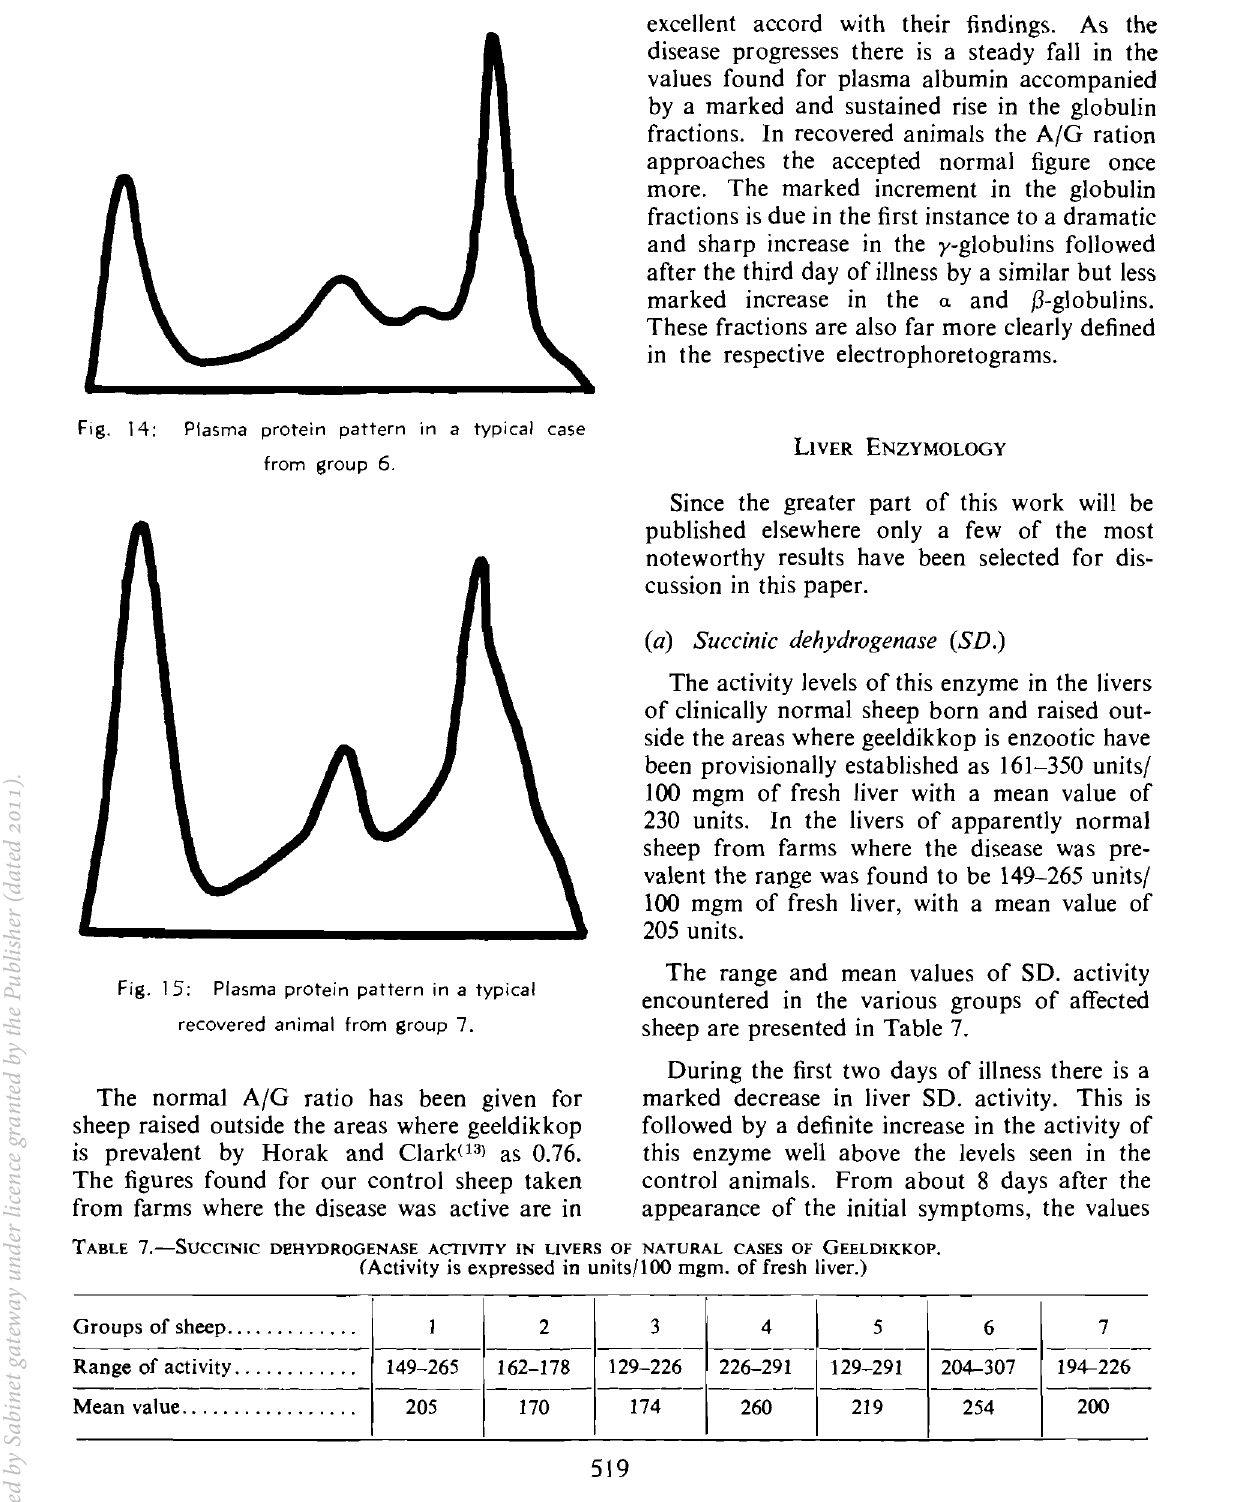
TABLE 7.-SUCCINIC DEHYDROGENASE ACTIVITY IN LIVERS OF NATURAL CASES OF GEELDIKKOP. (Activity is expressed in units/I 00 mgm. of fresh liver.) Groups of sheep